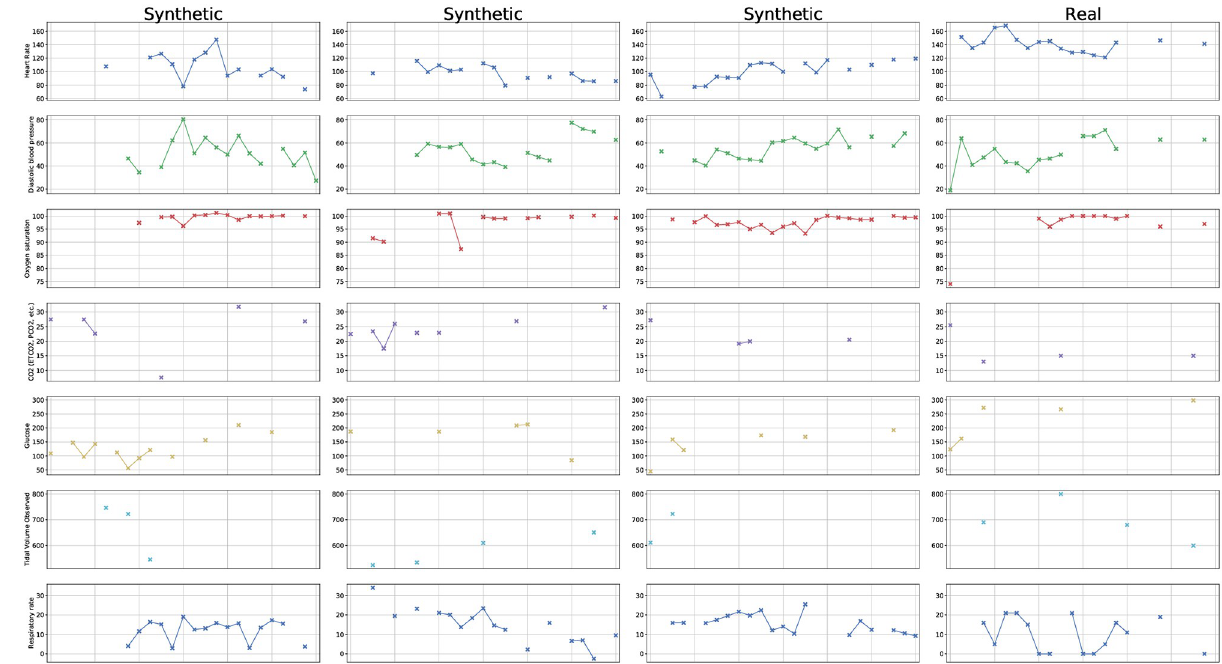
Fig 1. Sample time series of synthetically generated patients, with the time series of one real patient for comparison.